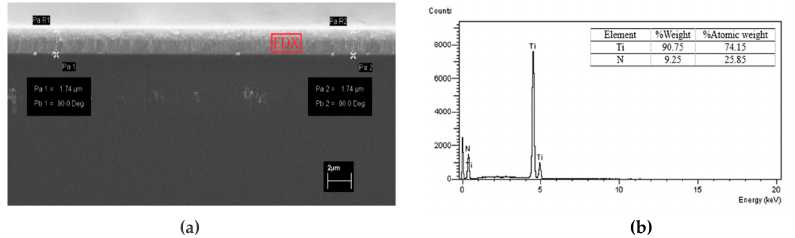
Figure 5. ( a ) Cross-sectional scanning electron microscope image of the TiN coating, ( b ) Energy dispersive X-ray